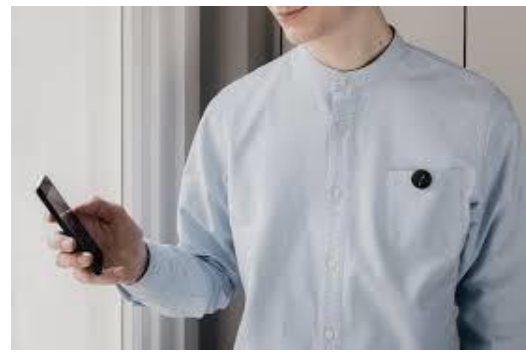
Figure 3. The LYS button and a smartphone.